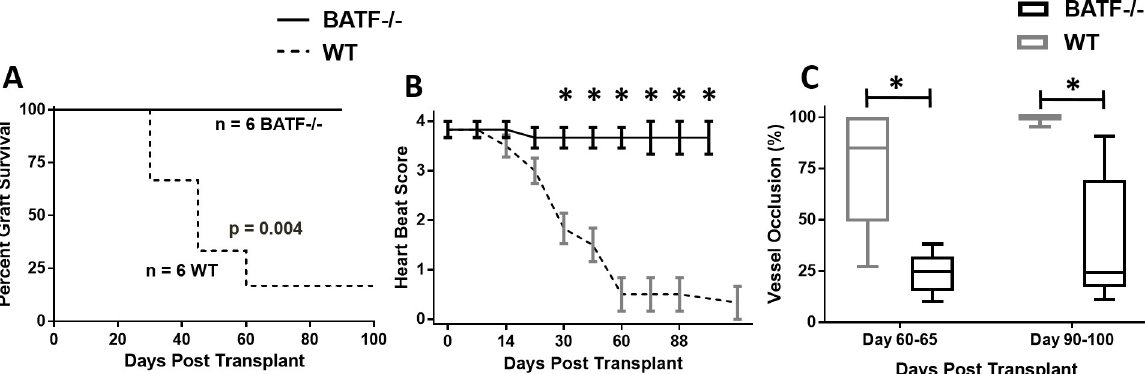
Fig 5. Heart transplant graft evaluation in BATF-/- mice in a chronic rejection model. Graft survival (A), heartbeat scoring (B), and vessel occlusion (C) over time in WT and BATF-/- recipient mice of heart transplants from bm12 mice. Significance approximated by Mantel-Cox test (A), 2-way ANOVA with Bonferroni post-tests (B), and unpaired Student’s t-test (C) � indicates p < 0.05. C) Grafts were recovered on the indicated day, cut, and stained for elastin. Percent occlusion was determined by tracing the internal elastic lamina and lumen of each vessel and calculated by % occlusion ¼ ½ Area of internal lamina �(cid:0) ½ Area of lumen � � 100 . The number of mice and vessels were as follows: Day 60–65 (7 WT and 3 BATF-/- ½ Area of internal lamina � mice per group, 16–27 vessels) and Day 90–100 (2–3 mice per group, 8–14